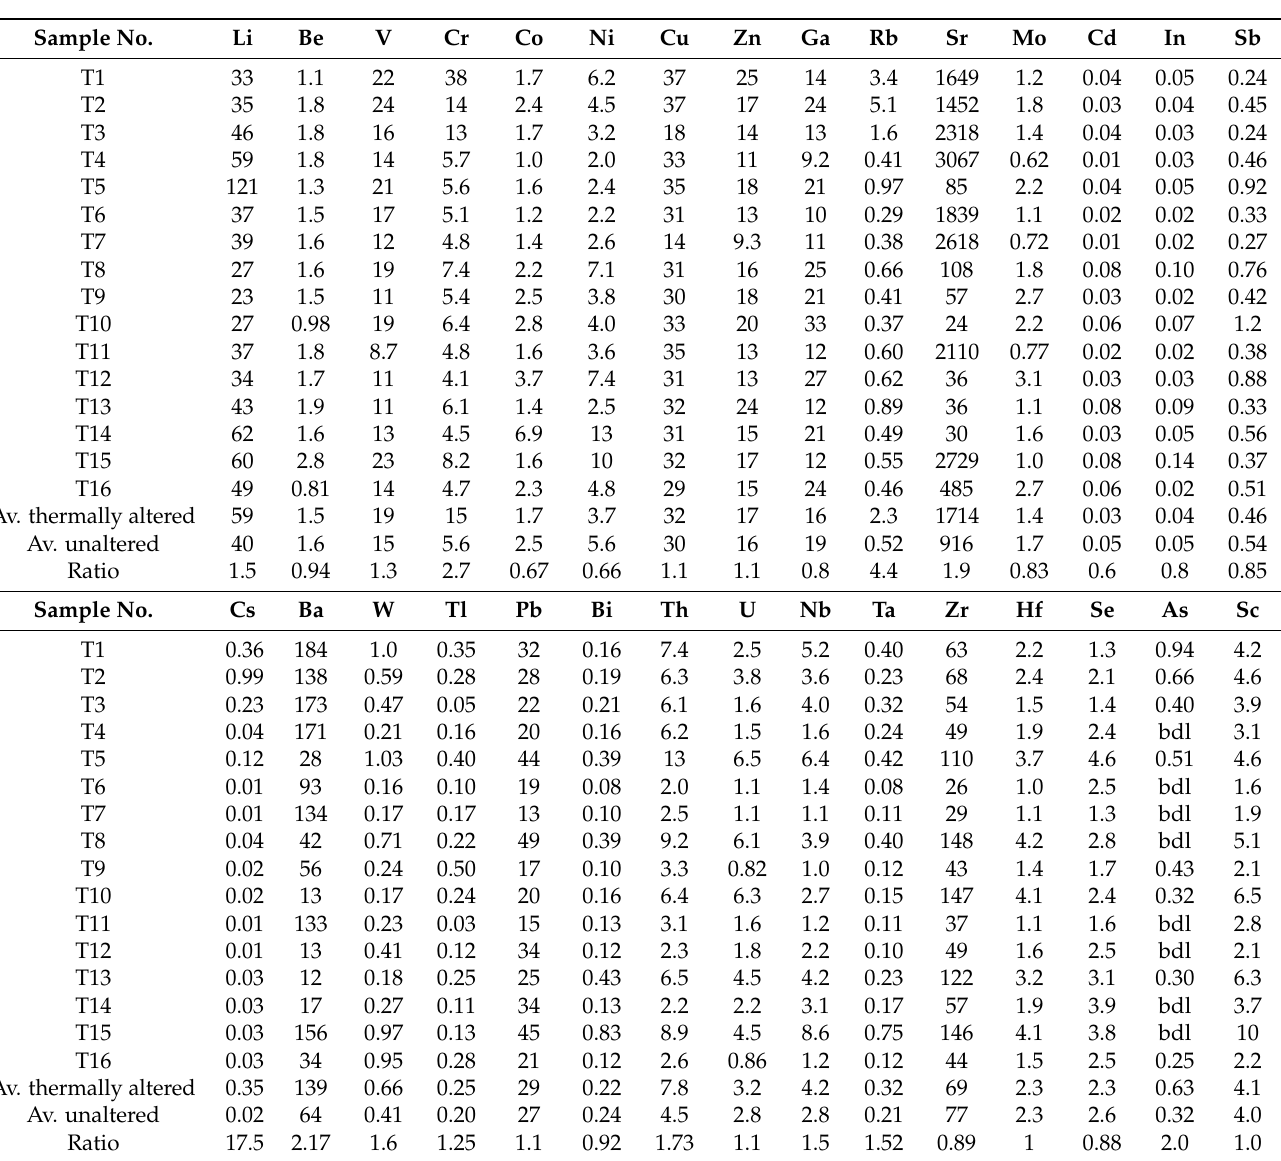
Table 7. Trace elements in the Tashan coal ( µ g/g, whole coal